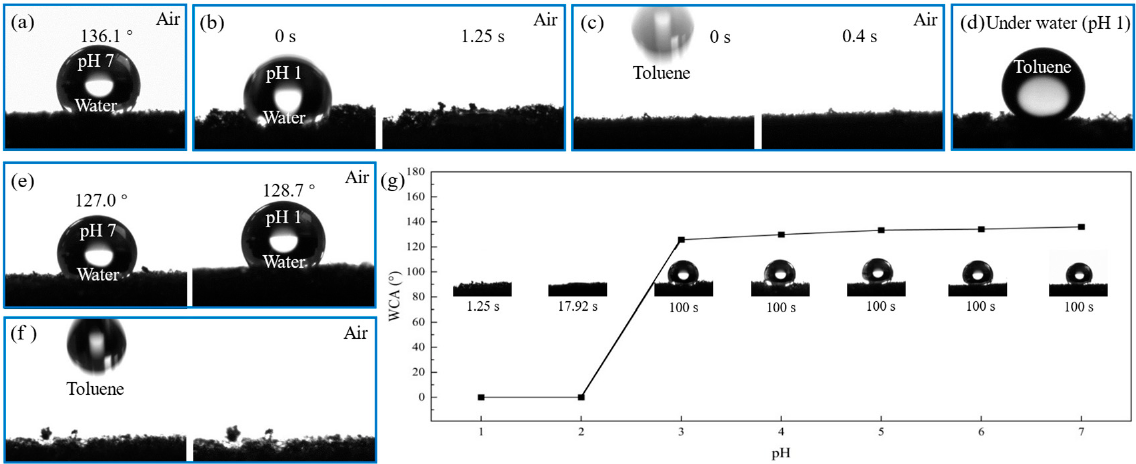
Figure 3. CA of CF and pH-responsive CF: ( a ) pH = 7 water drop stood on the surface of pH-responsive CF in the air; ( b ) pH = 1 water droplet was absorbed within 1250 ms in the air; ( c ) oil droplet was absorbed within 400 ms in the air; ( d ) oil droplet stood on the surface of pH-responsive CF under pH = 1 water; ( e , f ) unmodified CF; ( g ) comparison of resting time of water droplets with different pH